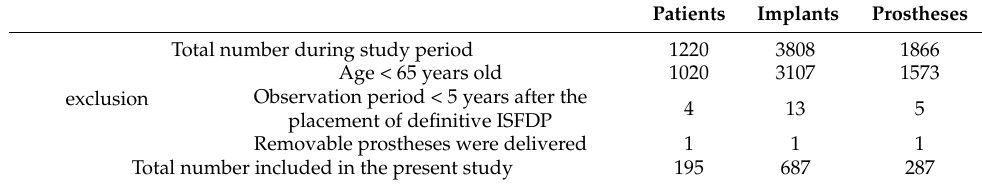
Table 1. Inclusion and exclusion of subjects.